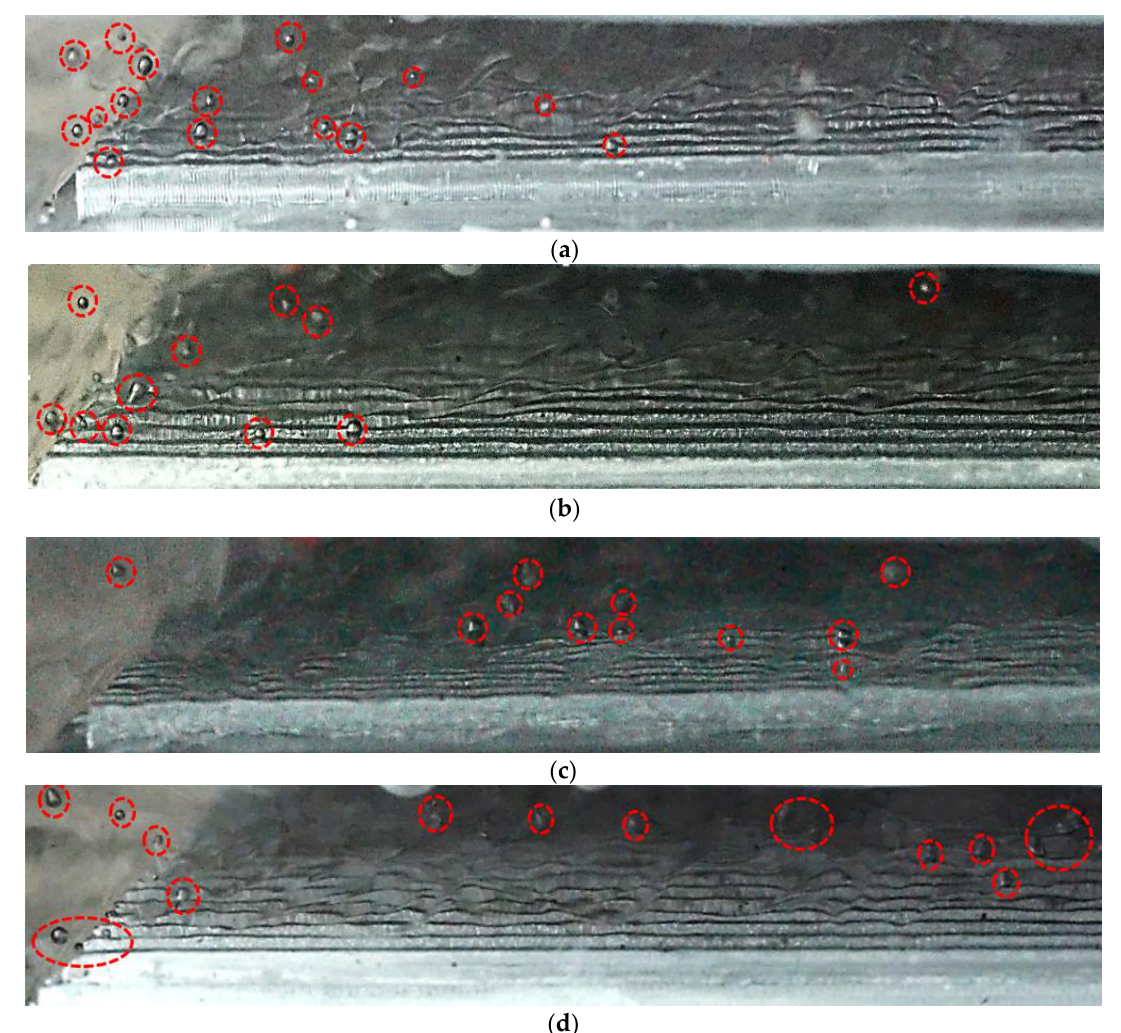
Figure 7. Bubble (indicated by red dotted circles) dynamics of the ( a ) R1, ( b ) R1.5, ( c ) T1 and ( d ) T1.5 test cases at power input 170 W and G = 6.6 kg/m 2 ∙s.